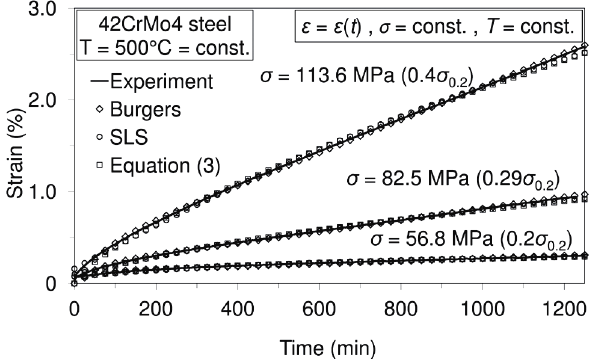
Fig. 7: Creep behavior modeling of 42CrMo4 steel at the temperature of 500 °C (773 K); case: e = e ( t ), s = const , T = const ; modeling using rheological models and analytical expression.